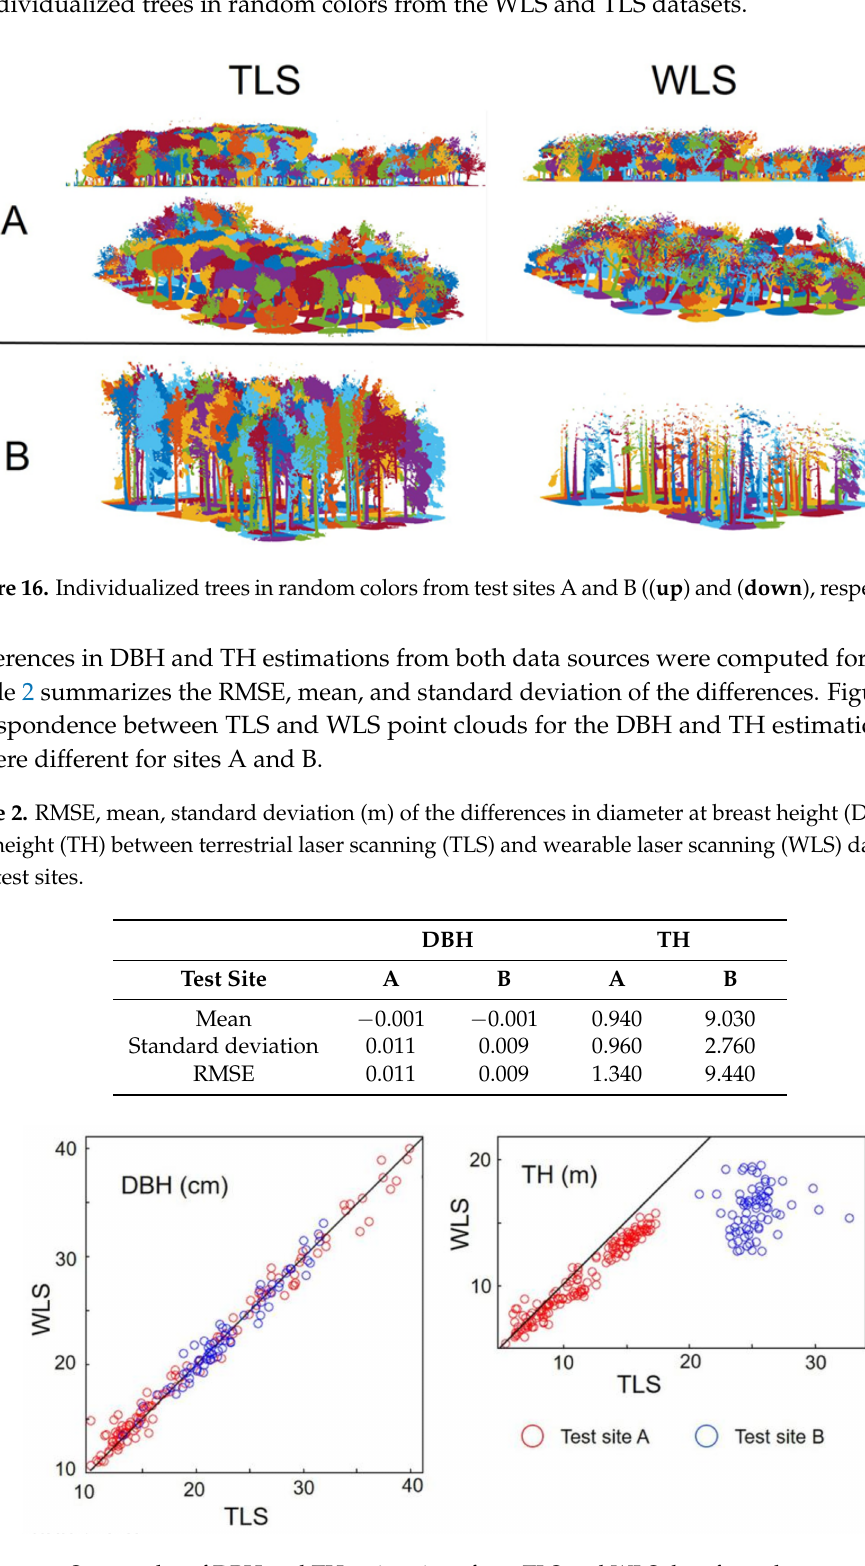
Figure 17. Scatter plot of DBH and TH estimations from TLS and WLS data from the two test